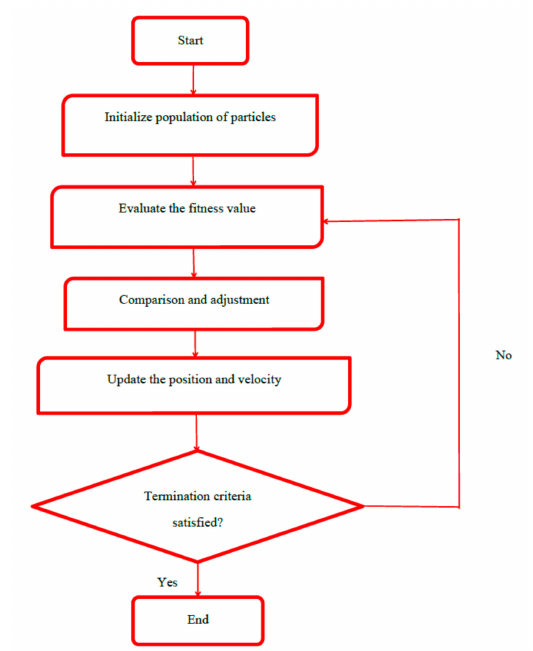
Figure 4. Flow diagram of particle swarm optimization